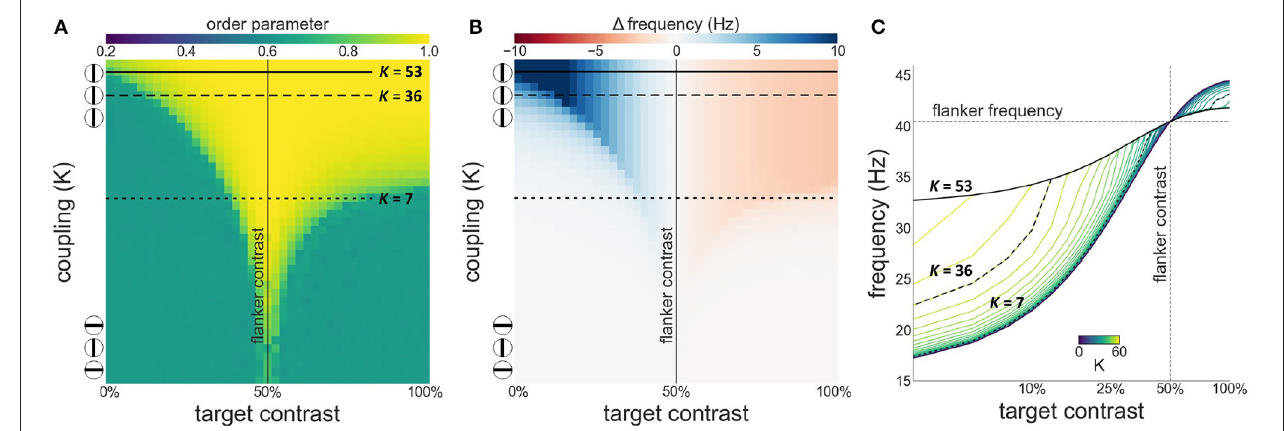
FIGURE 3 | Interactions between target and flanker populations. Flanker contrast is fixed at 50% (vertical line) while target contrast varies (x-axis). The three encircled lines and the top and bottom of the y-axis in (A,B) reflect the relation of the coupling strength ( K ) to collinearity of the target to the flankers. In this and subsequent Figures 4 , 7 : (A) Phase coherence among the three populations as a function of target contrast and coupling strength. (B) The difference between the observed (mean effective frequency) and intrinsic frequency of the target oscillator as a function of target contrast and coupling strength. Reflects facilitation and suppression of frequency. (C) The firing frequency plotted for various target contrasts and coupling values ( K ). Firing frequency of the horizontal black lines in (A,B) is represented by the highlighted black lines in (C)